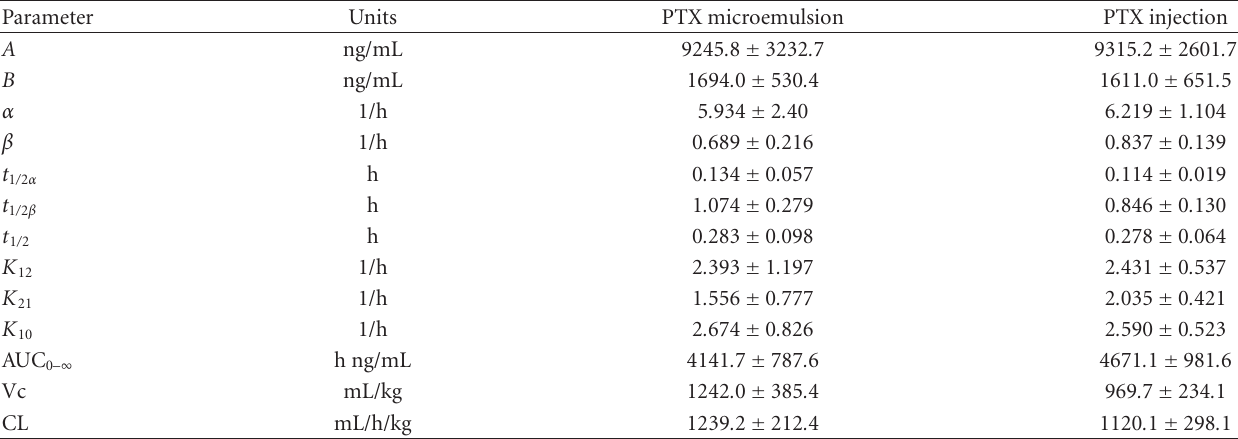
Table 2: The main pharmacokinetic parameters of PTX after intravenous administration of the PTX injection or microemulsion at 5mg/kg PTX in SD rats (mean ± S.D., n = 5).